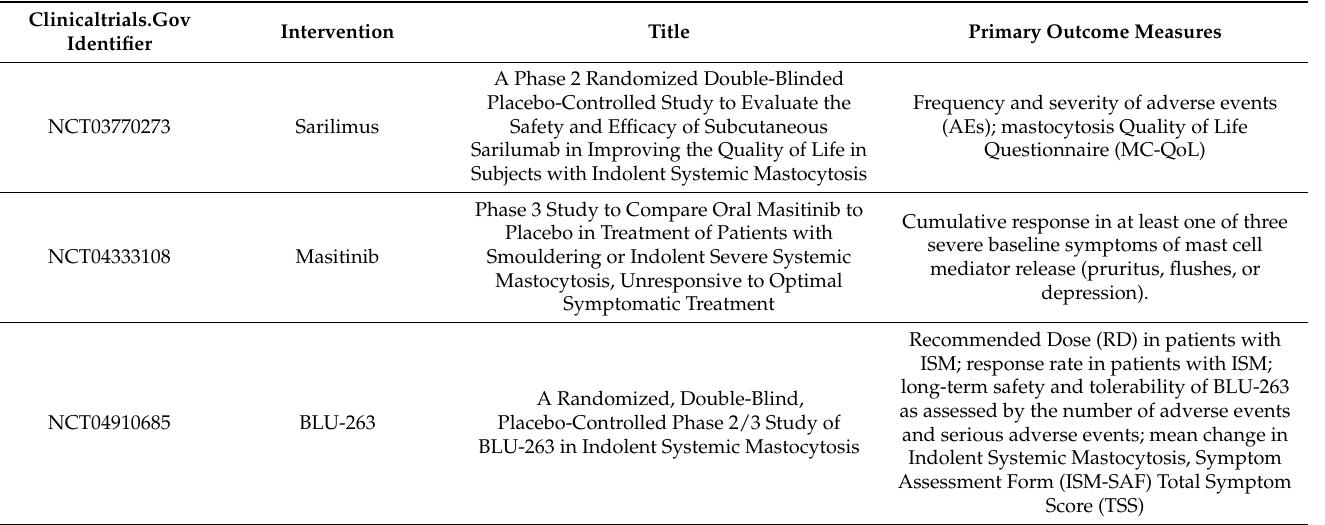
Table 5. Principal recruiting clinical trials involving